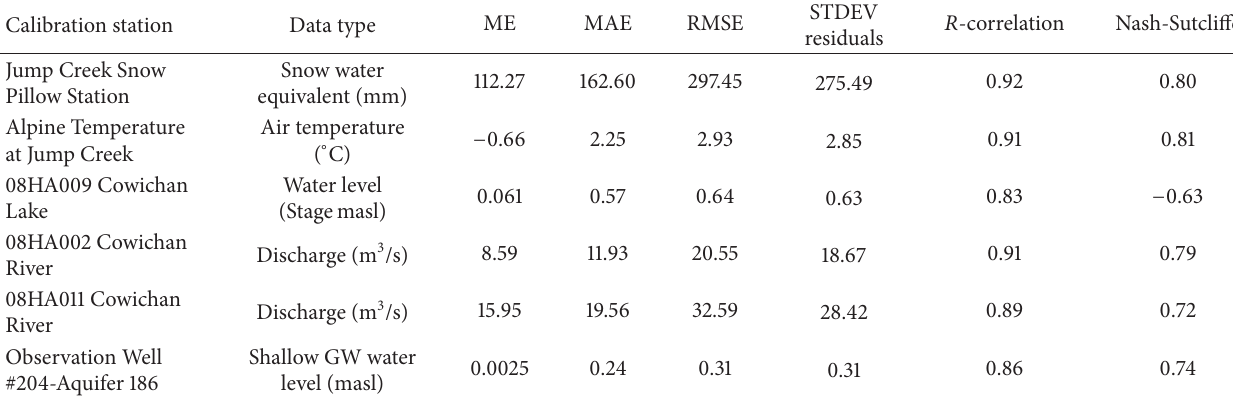
Table 4: Calibration results for snowmelt, lake level, stream discharge, and groundwater level (1998–2010). Calibration